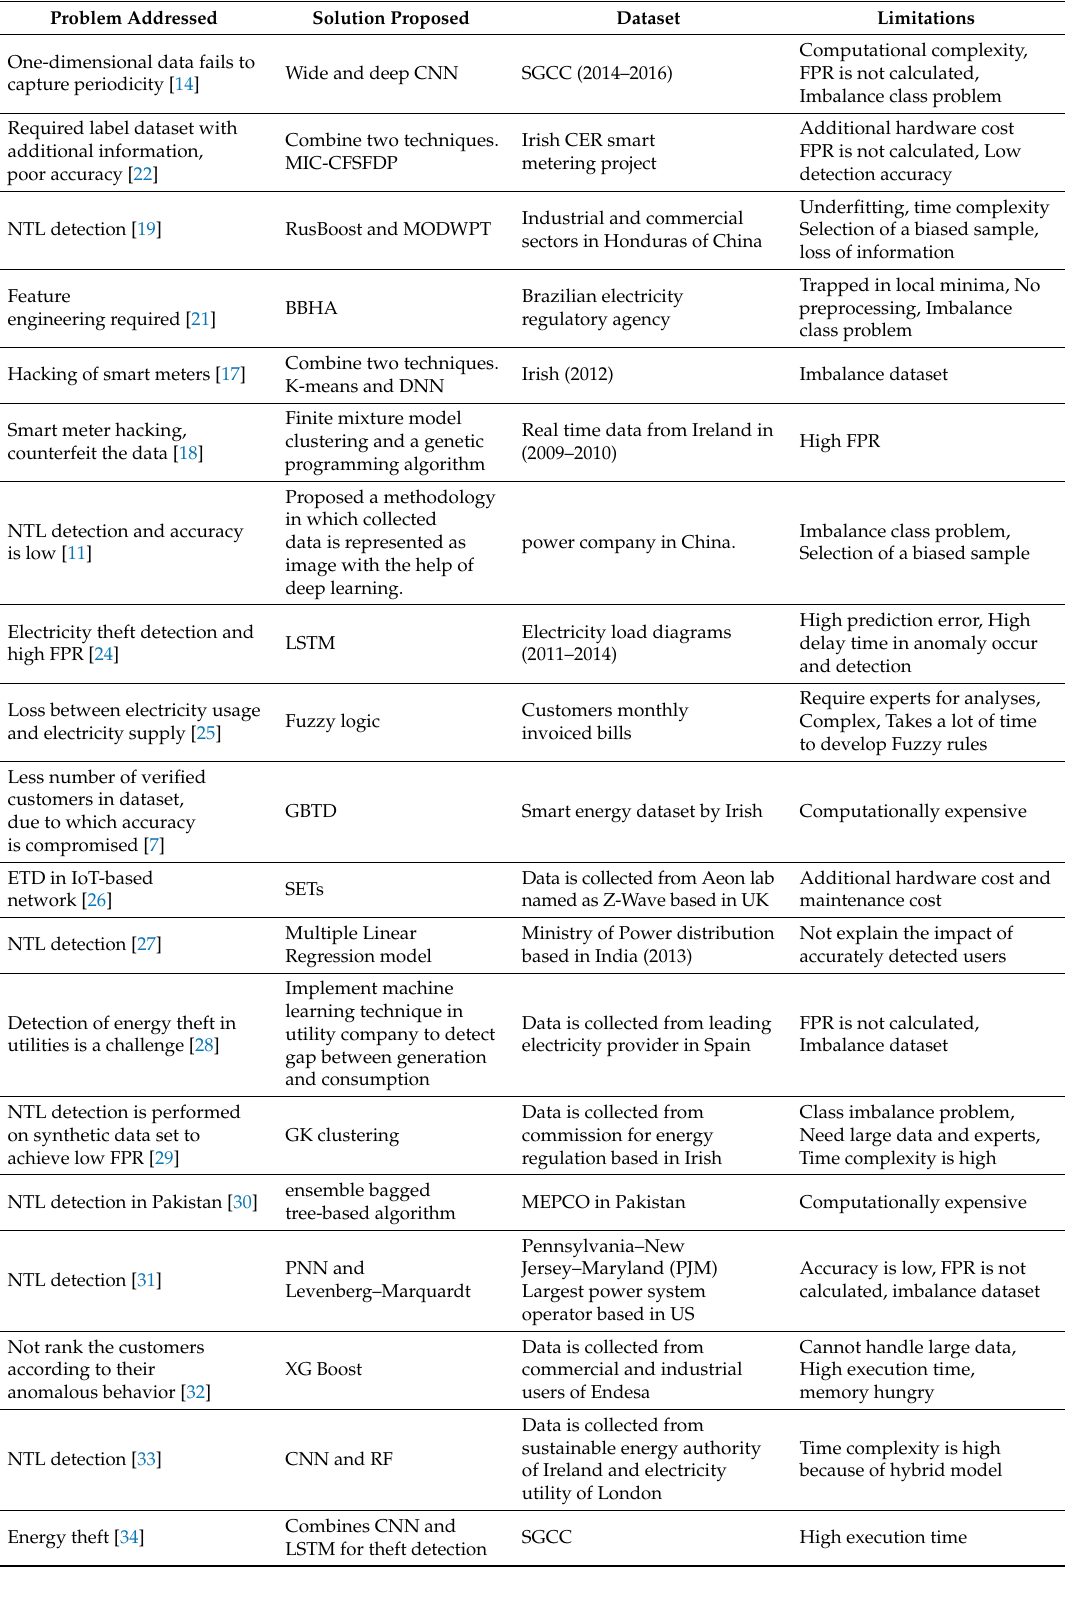
Table 2. Overview of existing